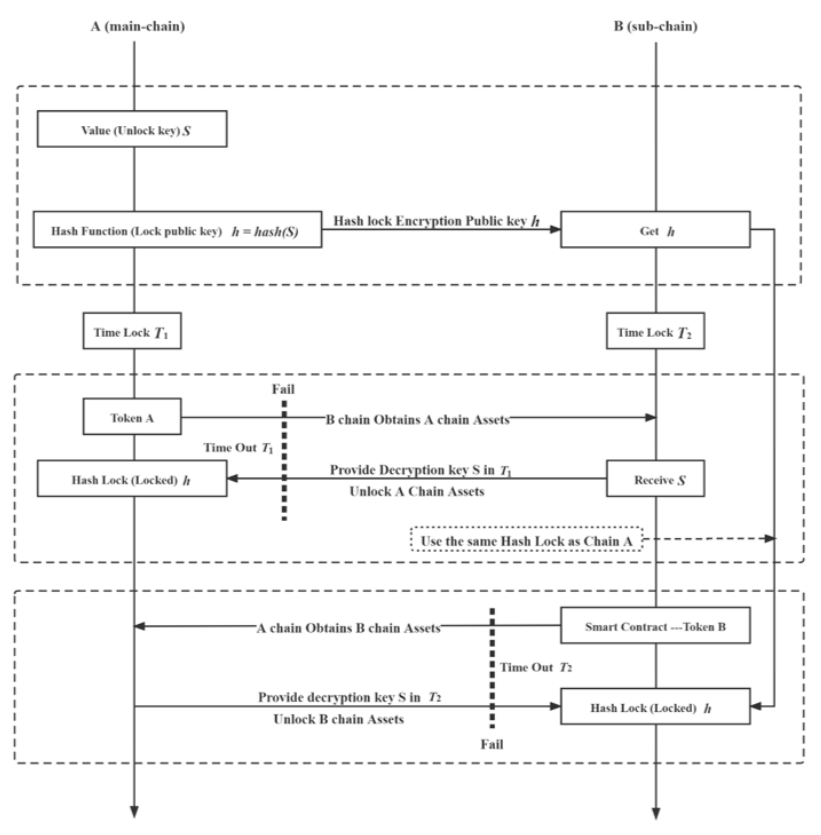
Figure 3. The principle of hash lock and hash time in cross-chain communication.